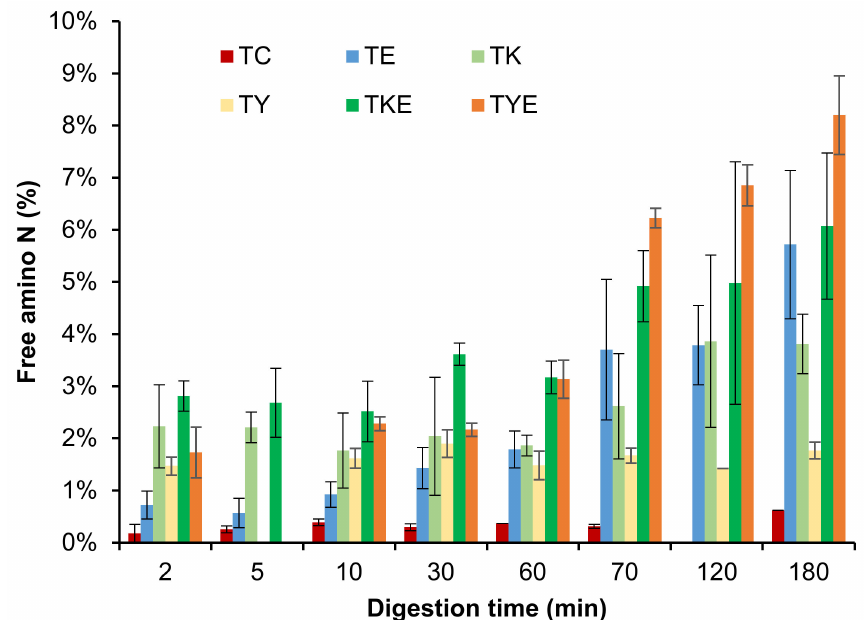
Figure 10. Free amino N (%) release during simulated gastro-small intestinal digestion of tofu in the presence or absence of Hayward or SunGold kiwifruit extract. TC, tofu (T) control without any digestive enzymes; TK/TY, with added green/gold kiwifruit extract but no digestive enzymes; AE, with digestive enzymes but no added kiwifruit extract; TKE/TYE, with both digestive enzymes and green/gold kiwifruit extract. Numbers 2, 10, 30 or 60 is the gastric digestion time following 2 min of oral digestion. Numbers 70, 120 or 180 are the total digestion times in oral-gastro-small intestinal digestion (including the first 60 min of gastric